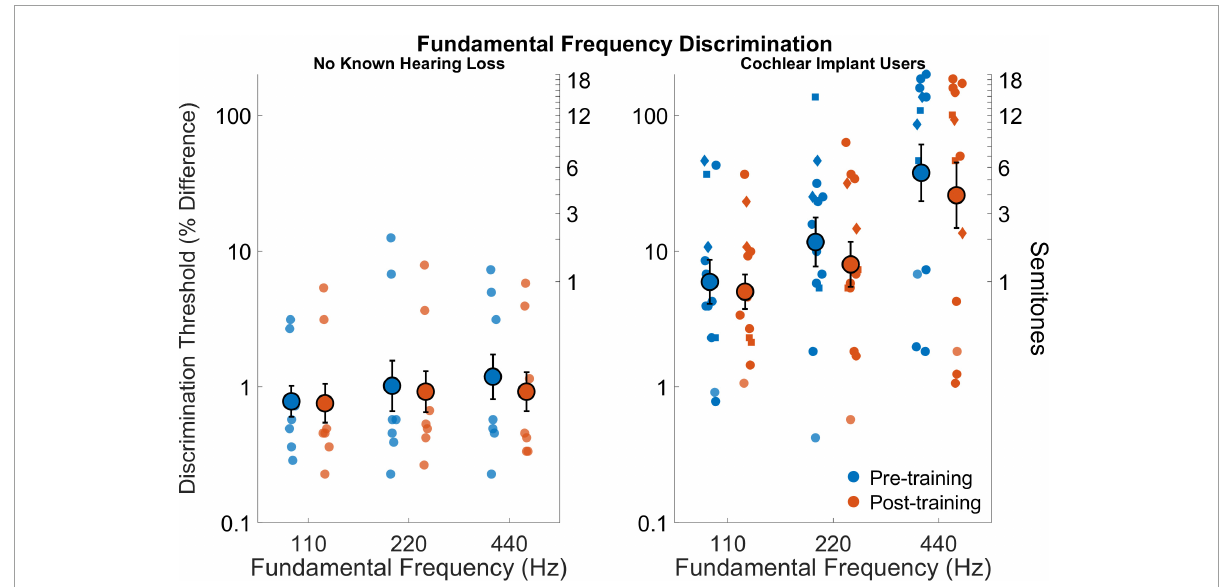
FIGURE4 Fundamental frequency discrimination thresholds as percent difference on a logarithmic scale (left y axis) and semitones (right y axis) for fundamental frequencies 110, 220, and 440 Hz for participants with no known hearing loss (left subpanel) and for cochlear implant users (right subpanel). Smaller symbols indicate individual thresholds. Individual thresholds for cochlear implant users with implants from Cochlear Corporation are represented with a circle, Advanced Bionics with a diamond, and MED-EL with a square. Larger circles indicate group averages for each session with error bars indicating standard errors of the means.